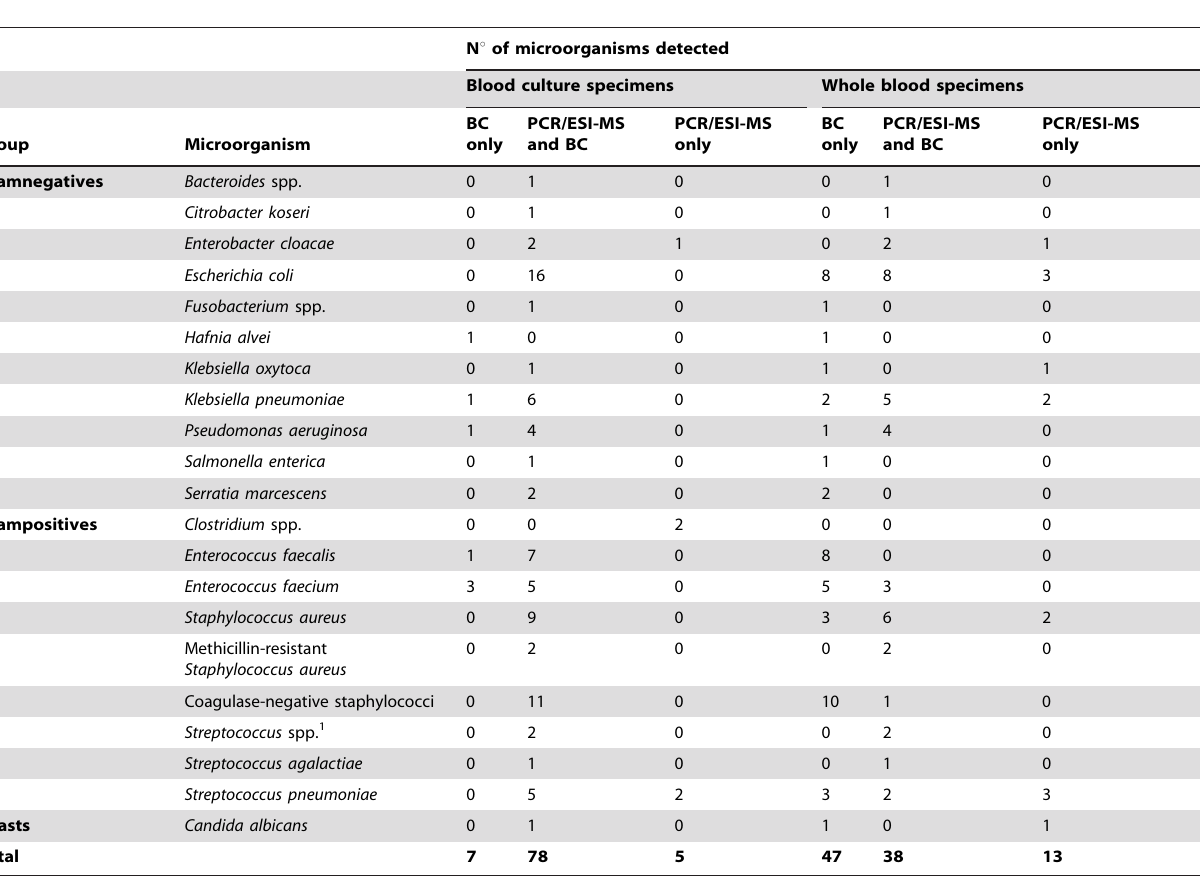
Table 3. Pathogens with clinical significance isolated by conventional microbiological methods and detected by the PCR/ESI-MS method.